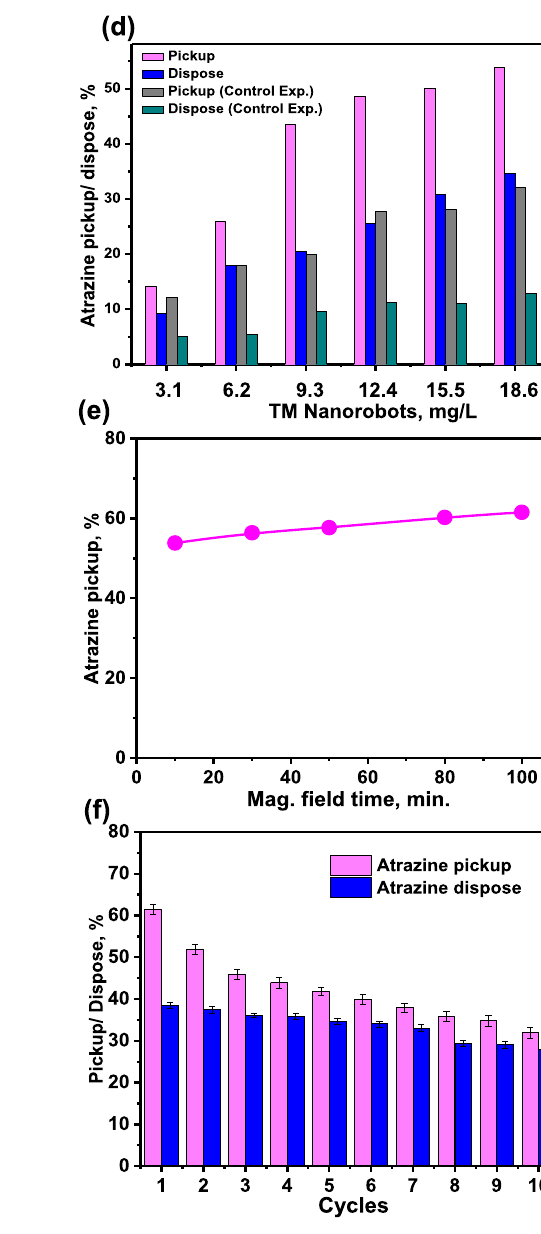
Fig. 5 Water remediation by TM nanorobots. ( a ) In fl uence of TM nanorobots ’ adsorbent dosage on pickup and disposal of arsenic (5 mg L − 1 ) under a transversal rotating magnetic fi eld (3 mT, 3 Hz for 10 min), whereas control experiment carried out an absence of magnetic fi eld. ( b ) Effect of rotating magnetic- fi eld time on pickup of arsenic by 18.6 mg of TM nanorobots and ( c ) recycling TM nanorobots for pickup and disposal of arsenic under a transversal rotating magnetic fi eld (3 mT, 3 Hz for 100 min). ( d ) Atrazine pickup and disposal as a function of TM nanorobots under a transversal rotating magnetic fi eld (3 mT, 3 Hz for 10 min), whereas control experiments were performed without a magnetic fi eld. ( e ) In fl uence of rotating magnetic- fi eld time on pickup of atrazine and ( f ) recycling TM nanorobots for pickup and disposal of atrazine under a transversal rotating magnetic fi eld (3 mT, 3 Hz for 100 min). The error bars in recycling TM nanorbots represent standard deviation based on three